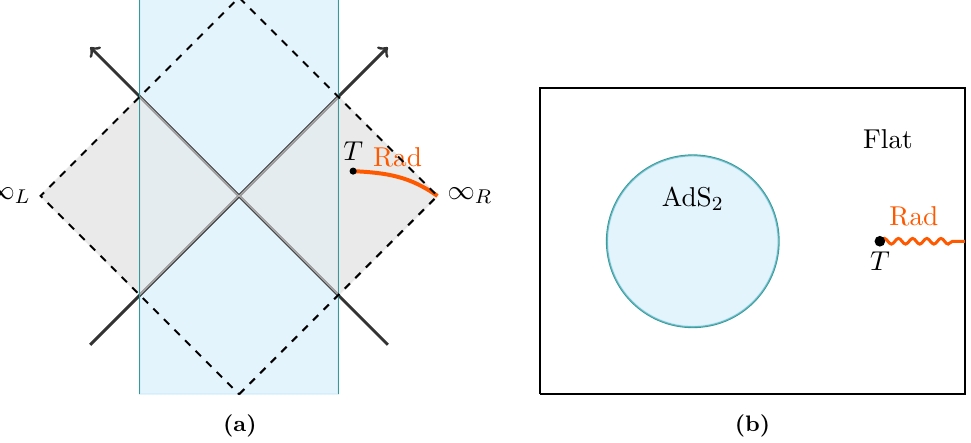
Figure 4. (a) The Lorentzian setup of a semi-infinite line region Rad = [ T, ∞ R ) in the flat bath. The entanglement entropy of Rad is IR divergent. (b) The Euclidean configuration where AdS 2 black hole (hyperbolic disk) is glued to the flat space.